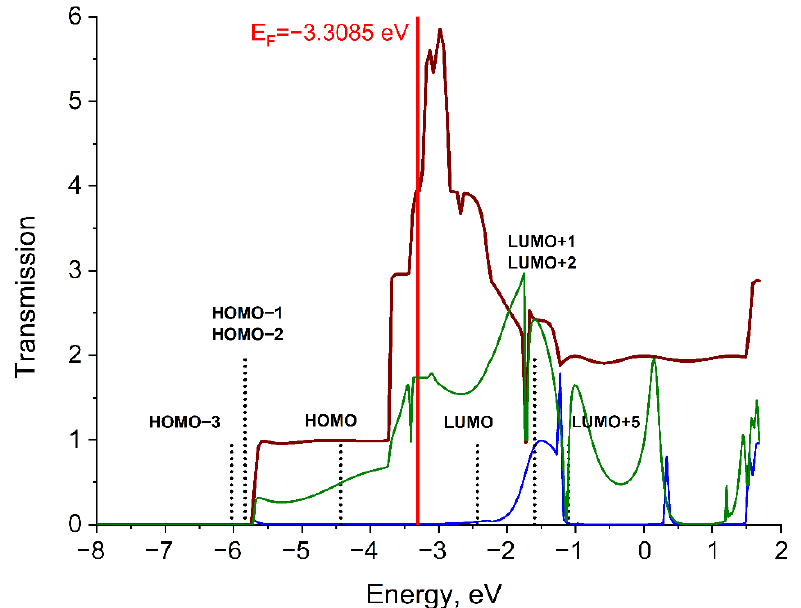
Figure 5. Transmission functions T DMT (E) (green for d(Ti-Mo) = 2.85 Å and blue for d(Ti-Mo) = 4.80 Å) for the Ti 6 –DMT–Ti 6 system and transmission function T wire (E) (brown) for the Ti 6 -Ti 6 system. E F denotes the Fermi level of electrodes. Energy positions of bonding ( σ , π , δ ) and antibonding ( σ *, π *, δ *) MOs are shown by vertical lines (black dots).